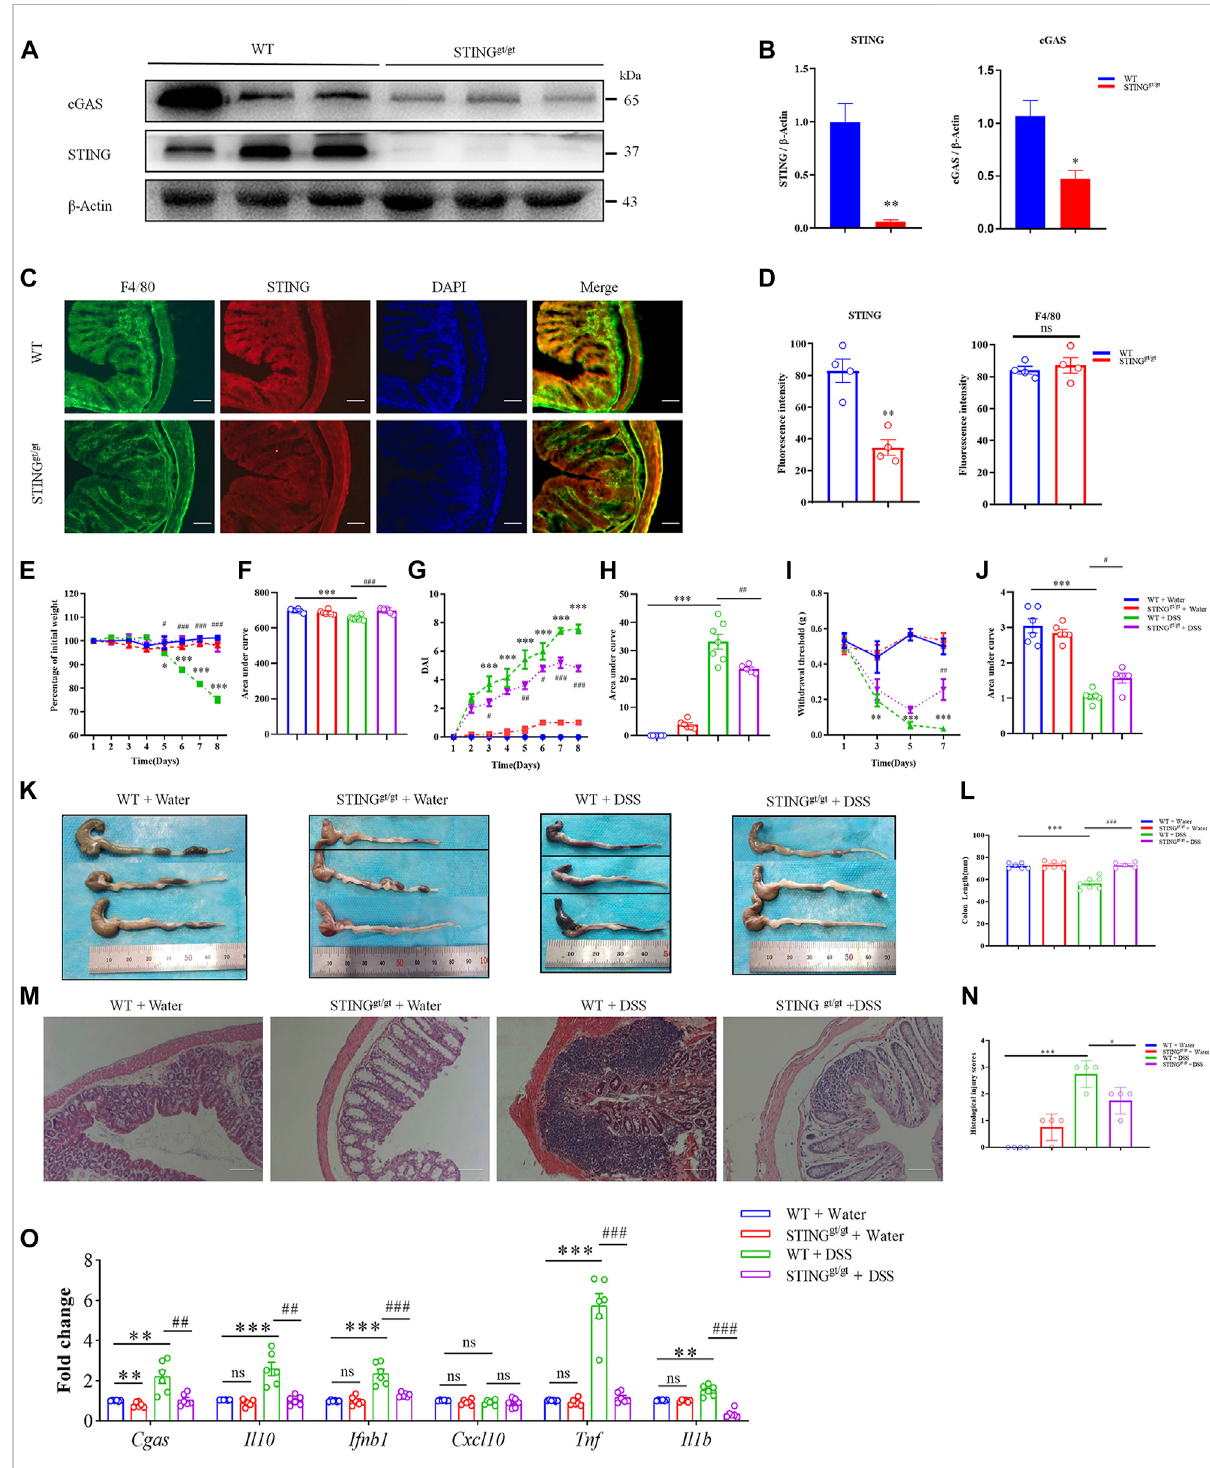
FIGURE 7 STINGde fi ciencyattenuatedDSS-colitisinmice. (A) RepresentativeWesternblottingdetectedcGASandSTINGexpressioninSTING gt/gt andWT mice. (B) Statistical analysis for (A) . (C) Representative immuno fl uorescence detected STING and F4/80 expression in STING gt/gt and WT mice. (D) Statistical analysis for (C) . ( n = 3 each group, ** p < 0.01, STING gt/gt vs. vehicle group; unpaired Student ’ s t -test). Wild-type (WT) and STING gt/gt mice were given 3% dextran sulfate sodium (DSS) in drinking water for 8 days. (E) Body weight changed following DSS administration in mice. (F) The quanti fi cationofAUCfor (E) . (G) DSS-inducedchangesofDAIscoreinWTandSTING gt/gt mice. (H) Thequanti fi cationofAUCfor (G) . (I)